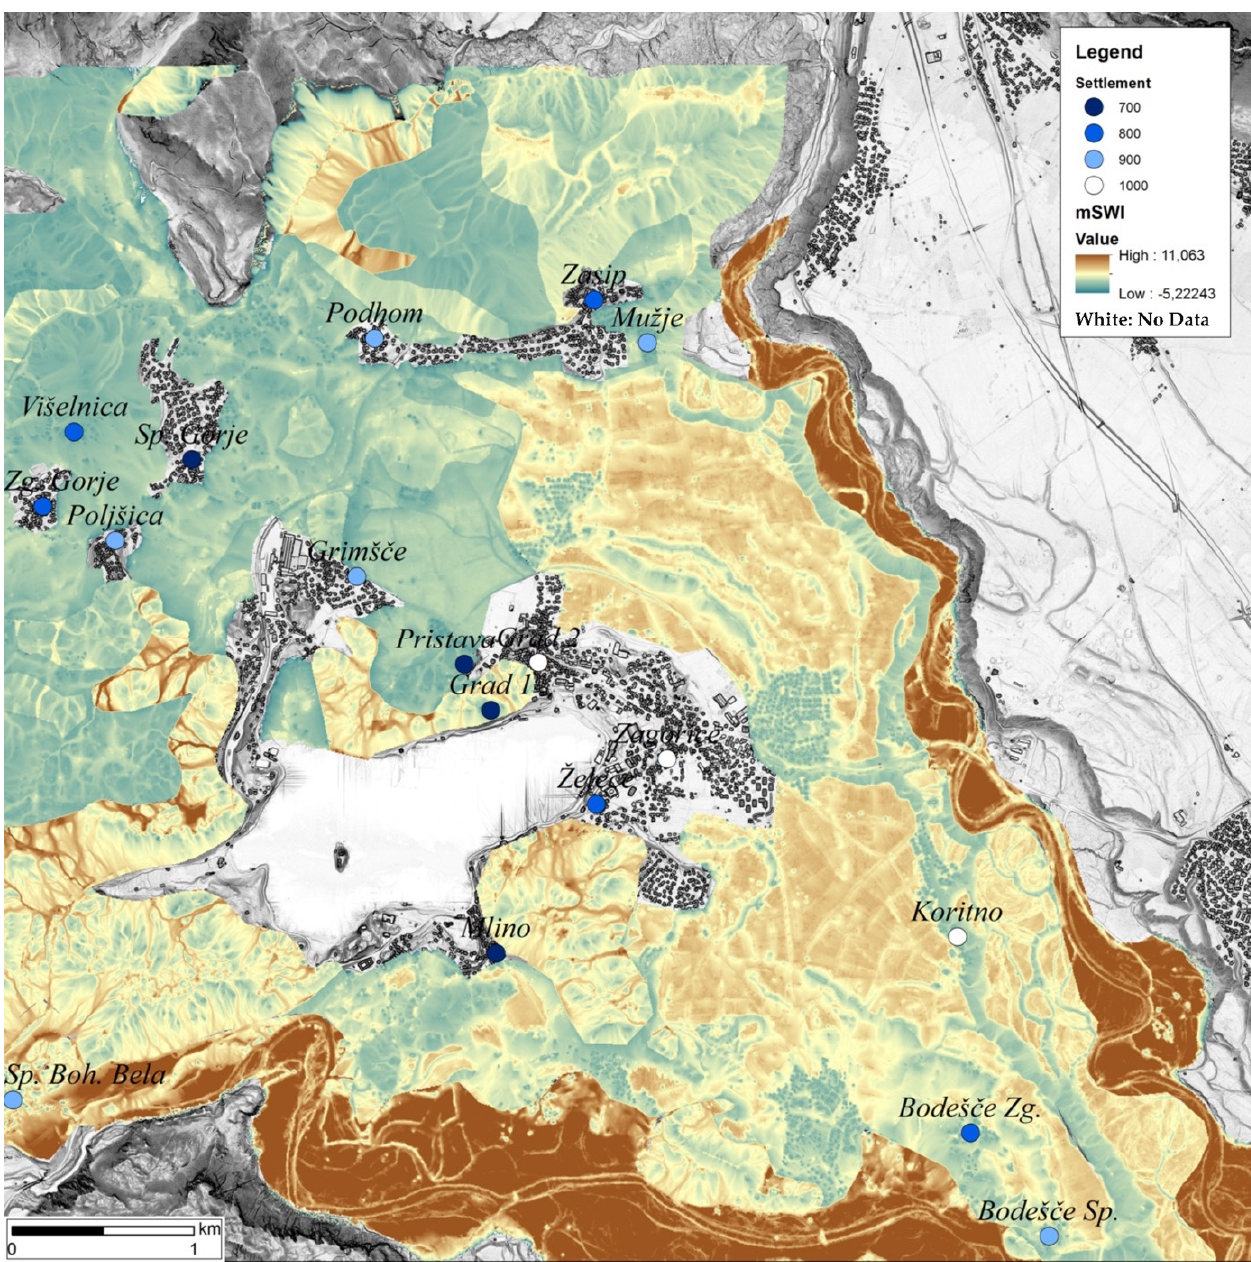
Figure A6. Bled microregion (decimal longitude and latitude coordinates of the map centre: 14.1139; 46.3752), modified SAGA wetness index (mSWI). The area with modified values between 11 and 0 has a (very) low capacity to retain water (map in yellow and brown), and the area with high capacity to retain water (values 0 to − 5, green). North at the top.